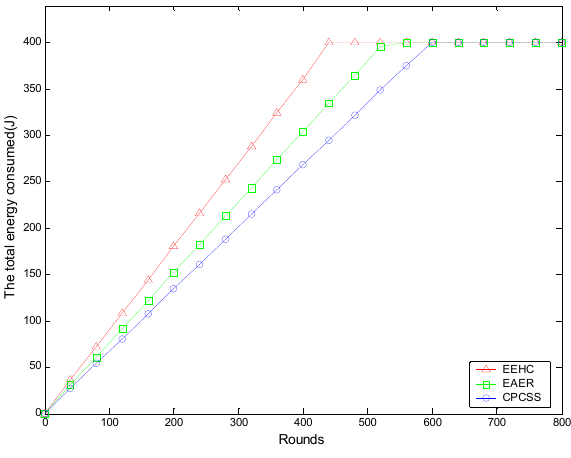
Figure 14. The total energy consumed over rounds.